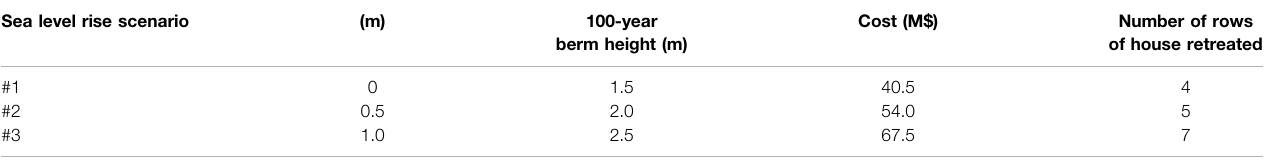
TABLE 1 | Dimensions and costs of berm and retreat.